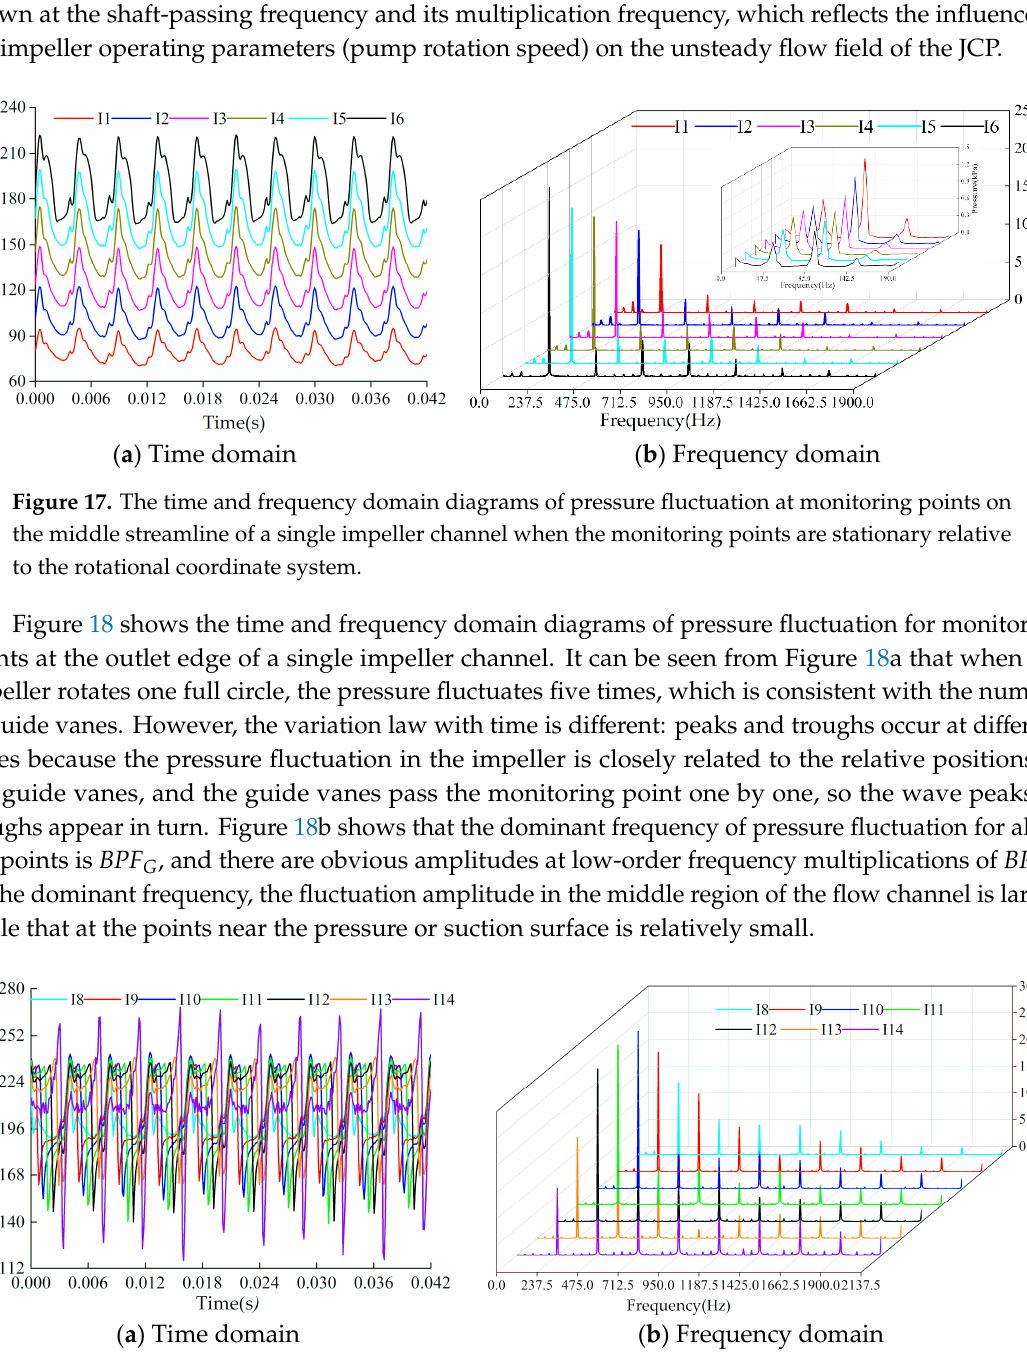
Figure 18. The time and frequency domain diagrams of pressure fluctuation for the monitoring points at the outlet edge of a single impeller channel.